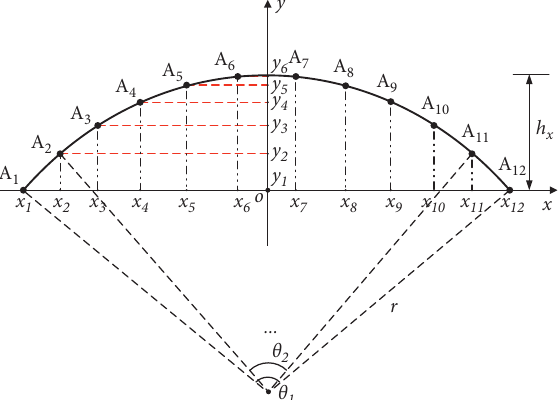
Figure 5: A sub-array of cylindrical conformal array in horizontal section, two-dimensional